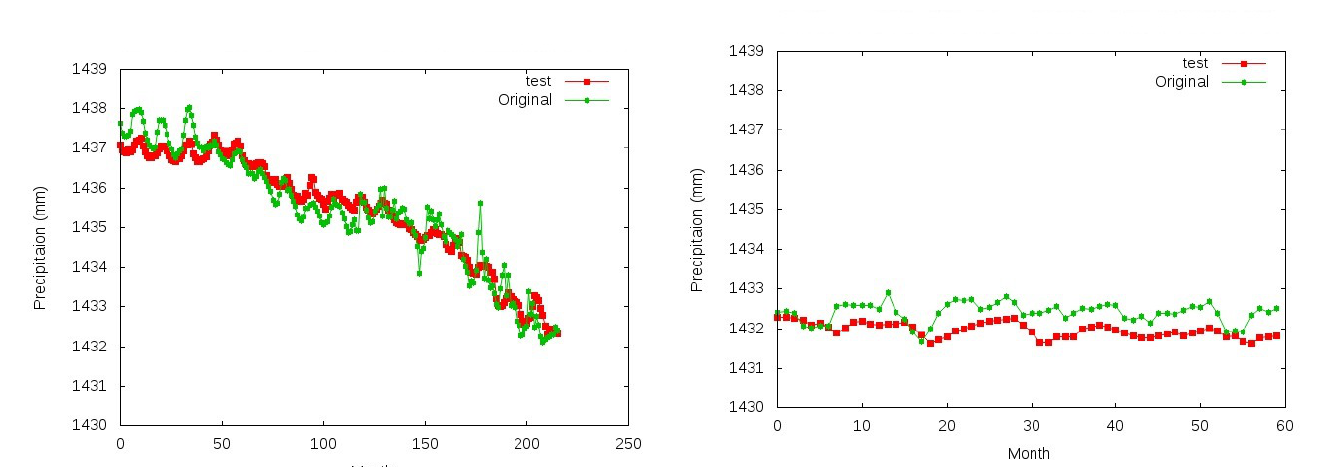
Fig. 12: Result under 500 hidden units and x